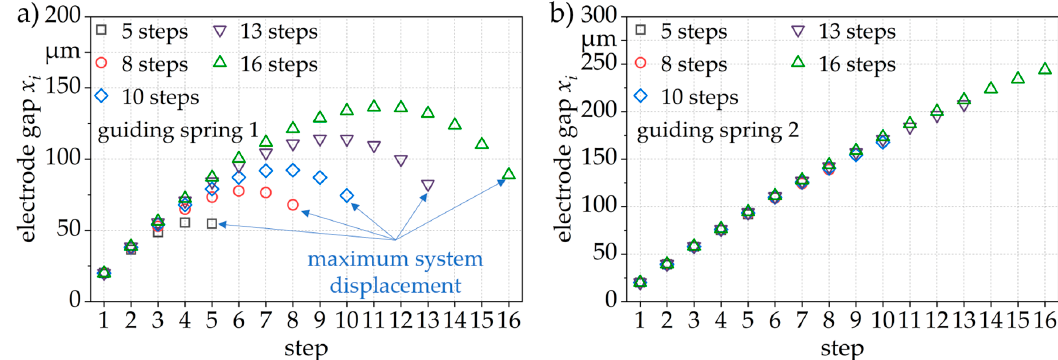
Figure 6. Analytically derived electrode gaps for systems with a mean stiffness value design featuring ( a ) guiding spring 1, ( b ) guiding spring 2.